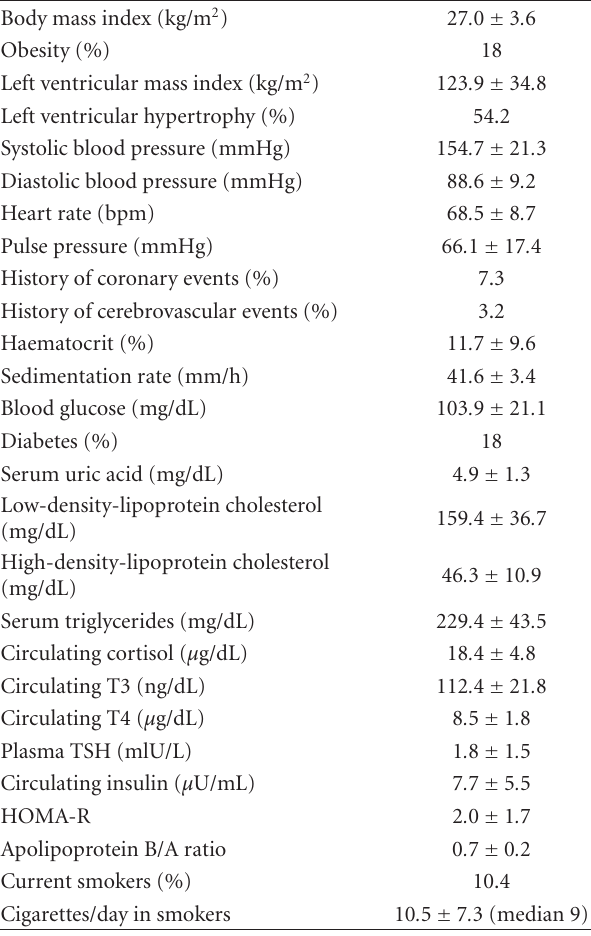
Table 1: General characteristics of the study